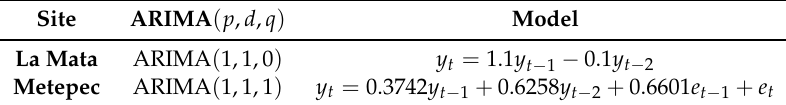
Table 3. ARIMA models for the two studied sites.